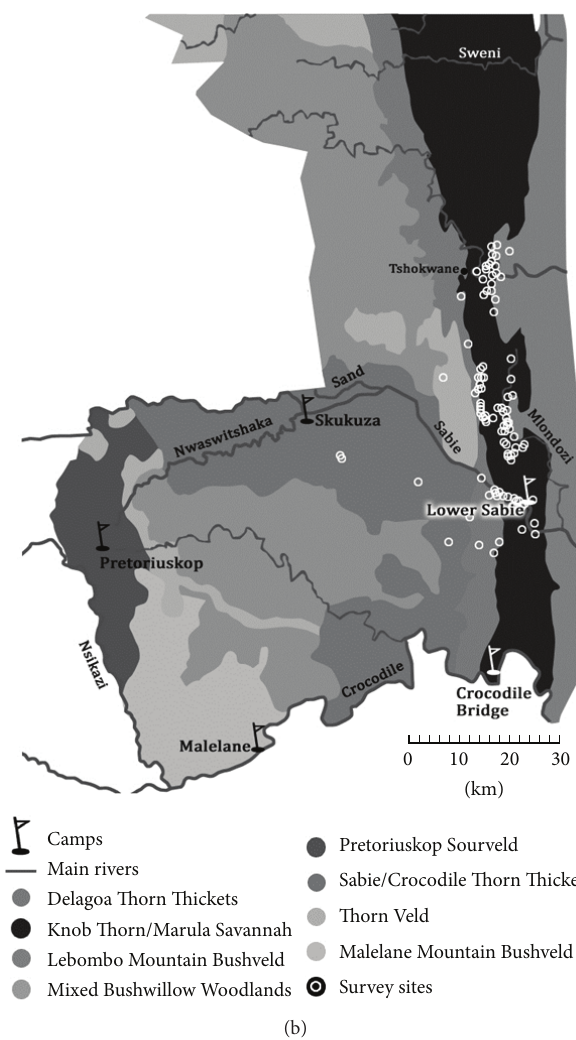
Figure 2: The movements of the breeding herds of elephants and location of the survey sites during the wet (a) and dry (b) seasons in the southern Kruger National Park from March 2002 to September 2005. (ecozones ex, Gertenbach [17]).